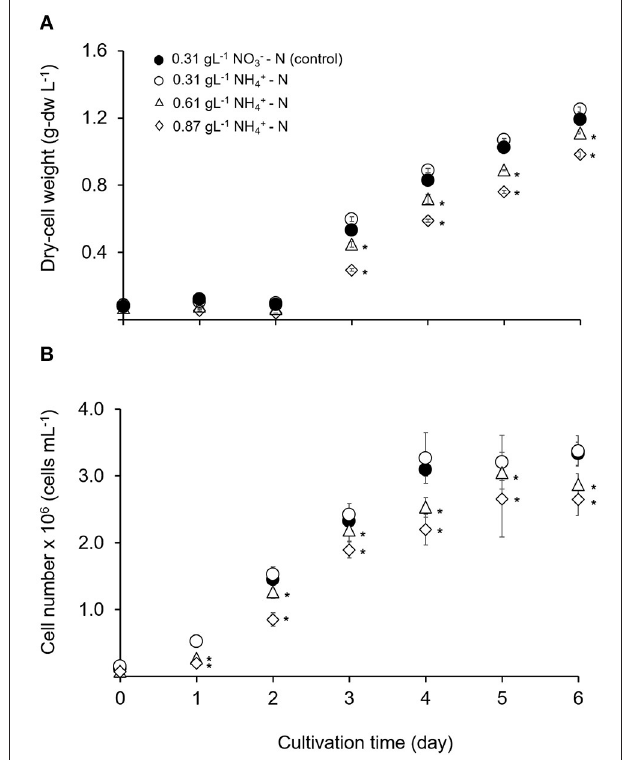
FIGURE 1 | Time course of growth performance for T. tetrathele in different concentrations of ammonium nitrogen. (A) Dry-cell weight (g-dw L − 1 ), and (B) cell number (cells mL − 1 ). Points marked with an asterisk indicate significant differences between treatments on that specific day, p < 0.05. Values are means ± SD ( n =